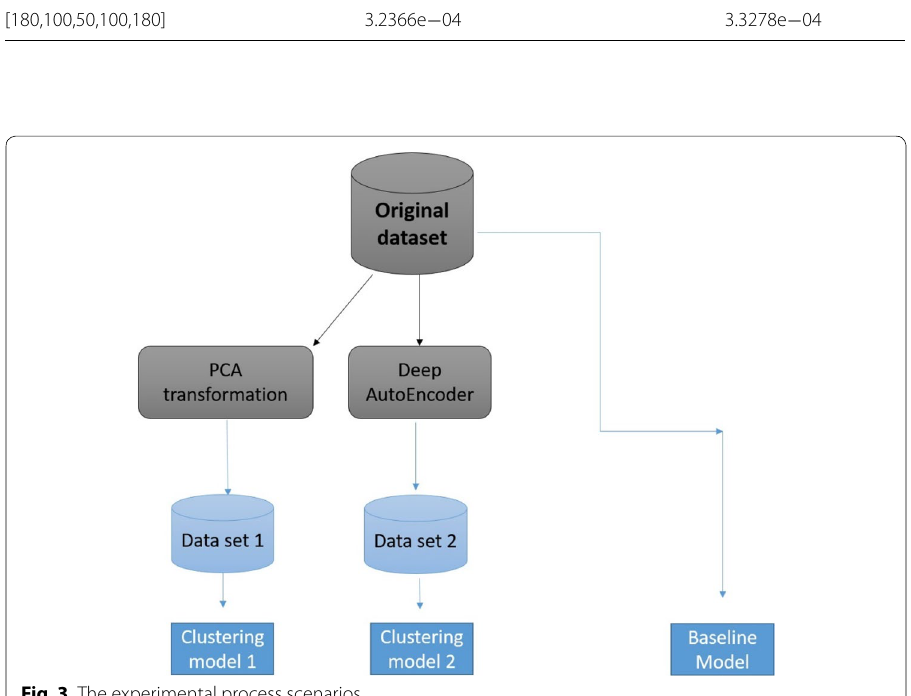
Fig. 3 The experimental process scenarios